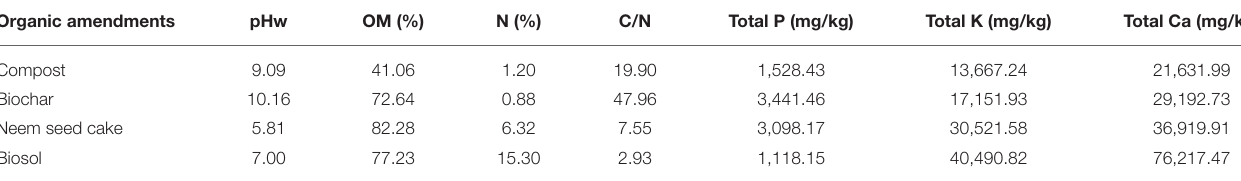
TABLE 1 | Characteristic of organic